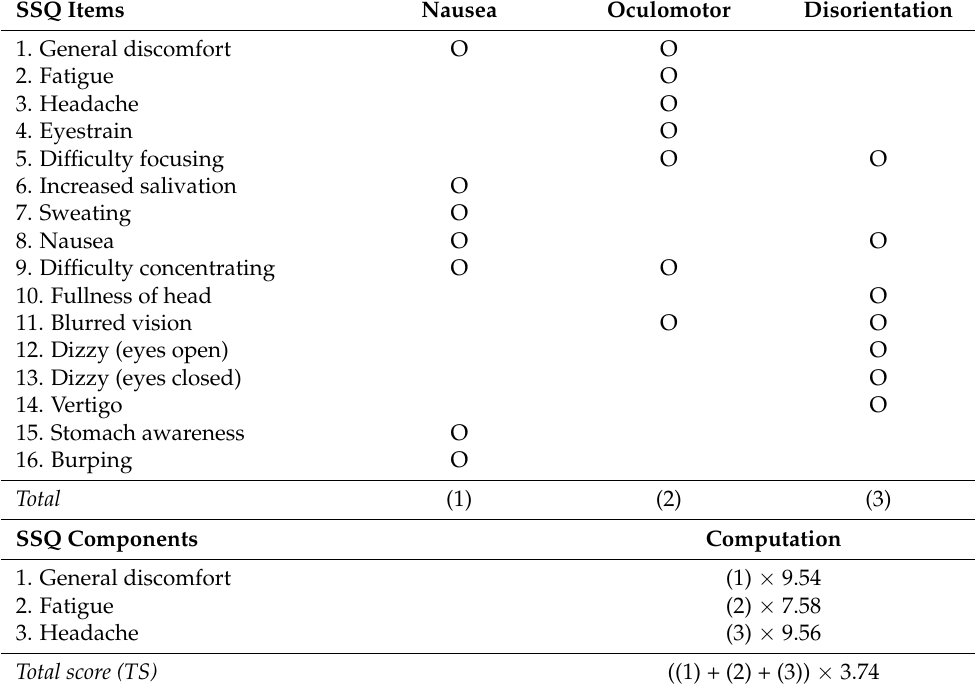
Table 2. Simulation Sickness Questionnaire